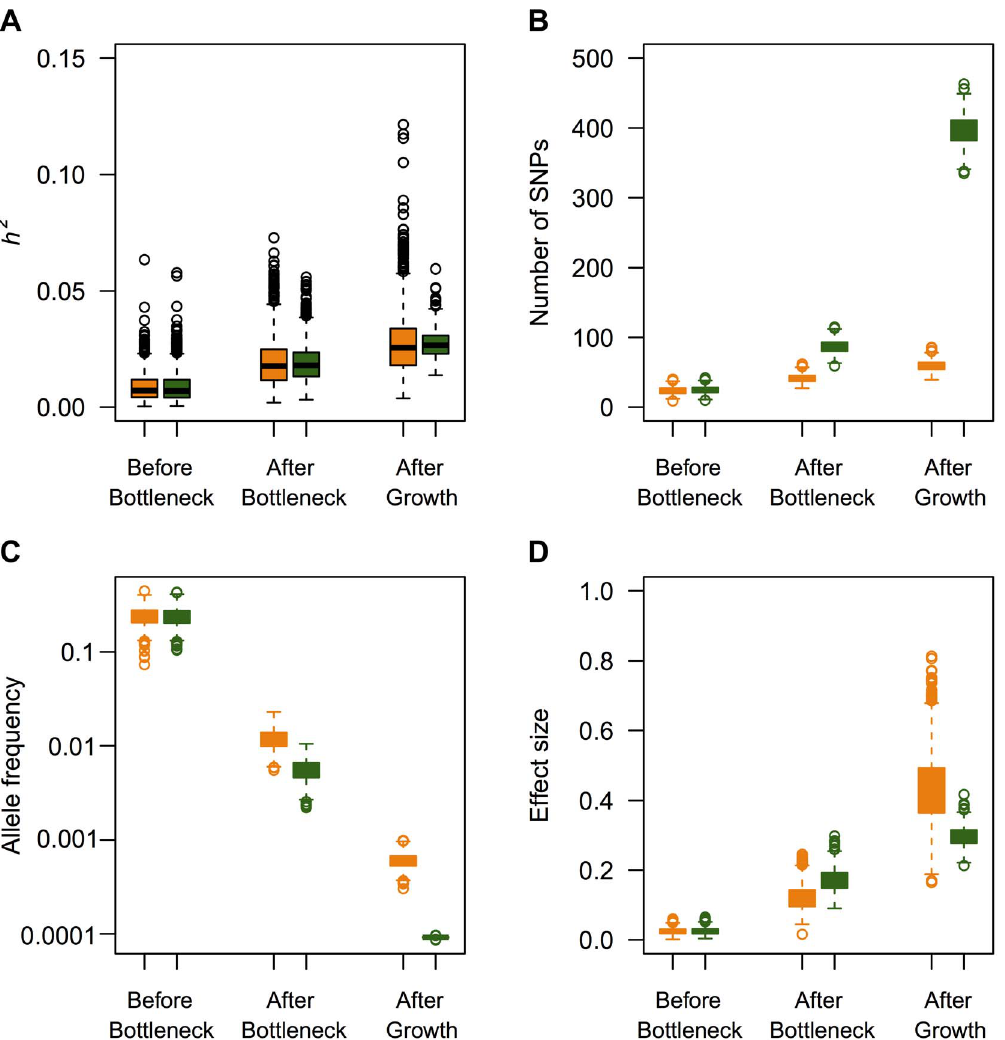
Figure 3. Effect of recent population growth on the heritability attributable to mutations of different ages when t =0.5. Orange boxes denote the bottlenecked population that did not recently expand (BN). Green boxes denote a population that expanded 80 generations ago (BN + growth). ‘‘Before bottleneck’’ refers to mutations that arose more than 1960 generations ago (before or during the bottleneck). ‘‘After bottleneck’’ refers to mutations that arose after the population recovered from the bottleneck, but earlier than 80 generations ago. ‘‘After growth’’ refers to mutations that arose within the last 80 generations (after the population expanded). ( A ) Heritability attributed to mutations of different ages. Note that recent population growth does not affect the median heritability attributable to mutations of different ages. ( B ) Number of SNPs segregating in the present-day that arose during the different time intervals. ( C ) Mean allele frequency of SNPs that are segregating in the present- day that arose during the different time intervals. ( D ) Mean effect size of SNPs that are segregating in the present-day that arose during the different ~ 0 : 05 and M =70 kb. time intervals. Here h 2 C